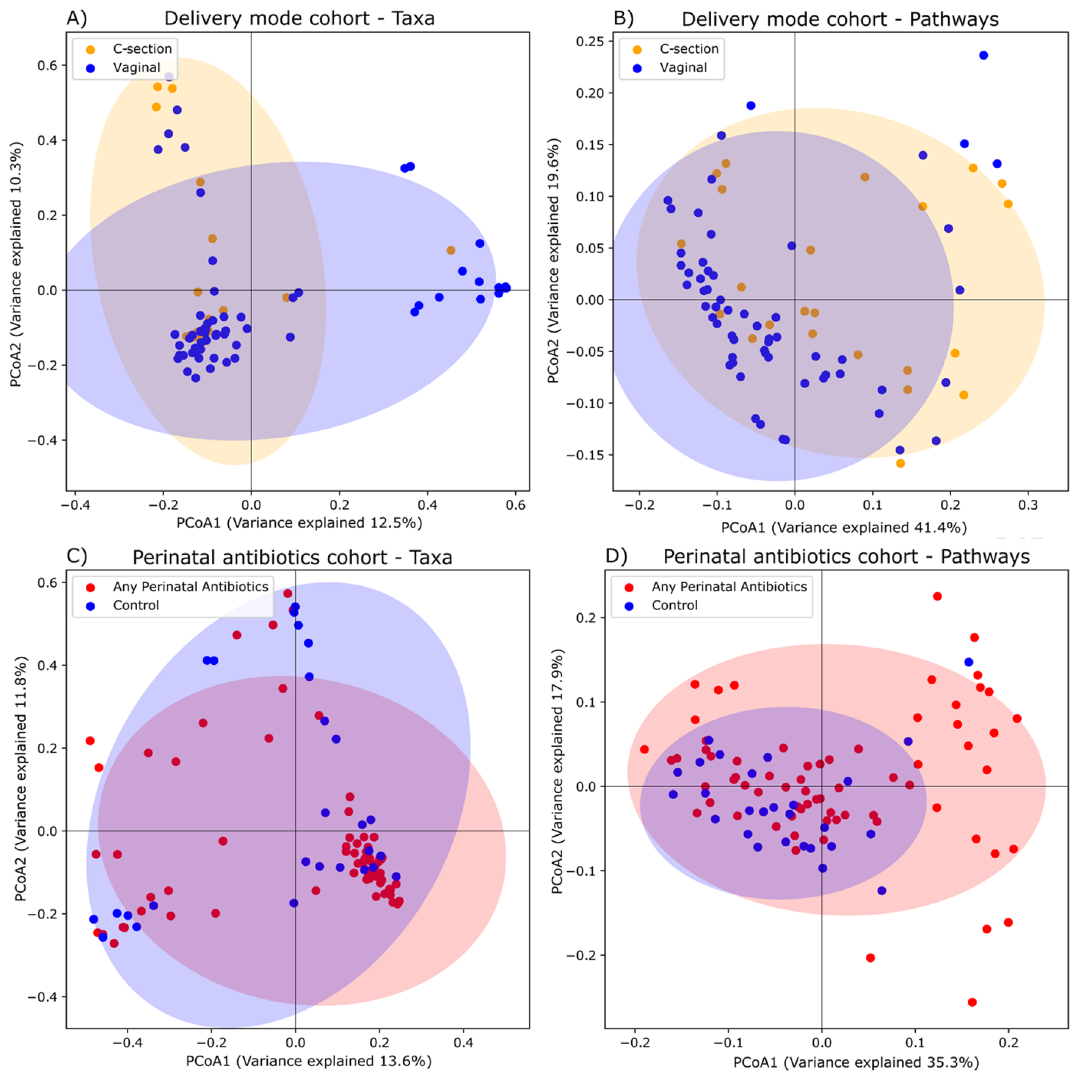
Figure 1. Principal coordinate analysis with Bray-Curtis dissimilarity with taxa and metabolic pathways. Confidence ellipses were drawn based on the Pearson correlation coefficient of the data points. ( A ) Impact of delivery mode on taxonomic composition of gut microbiome (PERMANOVA, R2 = 0.015, Pr (> F ) = 0.063). ( B ) Impact of delivery mode on metabolic pathway data composition (PERMANOVA, R2 = 0.017, Pr (> F ) = 0.3). ( C ) Impact of perinatal antibiotic exposure on taxonomic composition of gut microbiome (PERMANOVA, R2 = 0.020, Pr (> F ) = 0.008). ( D ) Impact of perinatal antibiotics on metabolic pathway data composition (PERMANOVA, R2 = 0.015, Pr (> F ) =